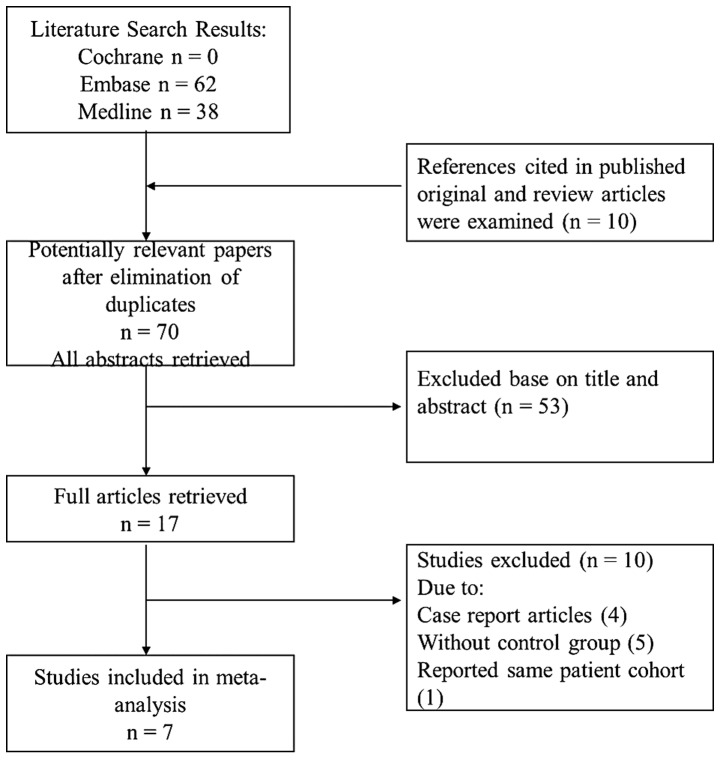
Flow chart of studies retrieved and studies excluded.